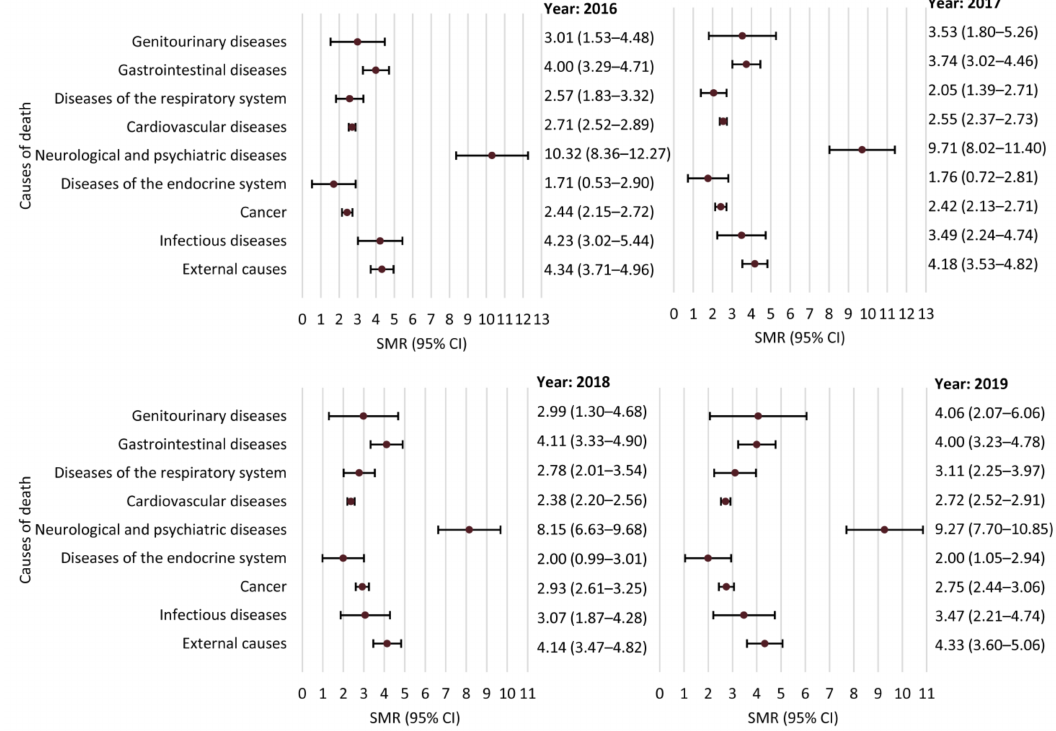
Figure 4. Standardized mortality ratios (SMRs) and 95% confidence intervals (CIs) for different groups of causes of